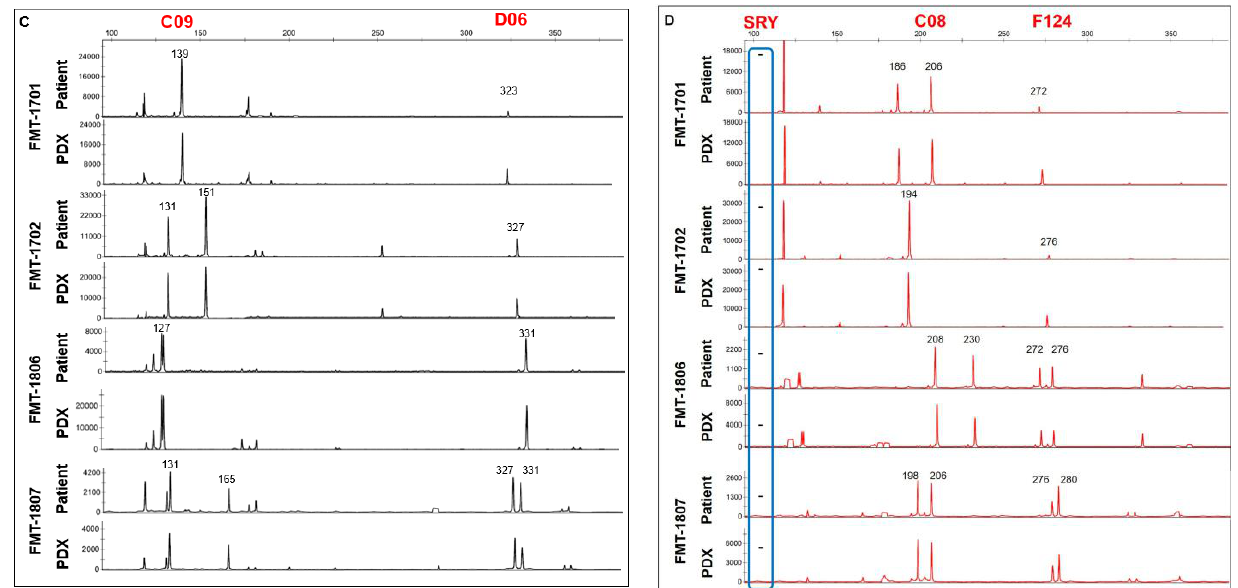
Figure 3. STR amplification of FMTs. Four nanograms of extracted DNA from patient cat tissues or PDX graft tissues were performed cat STR typing. The current dye labels used for the assay include 6-FAM (blue; A ), VIC (green; B ), NED (black; C ) and ROX (red; D ). X axis show the allele size, and the Y axis show the intensity.